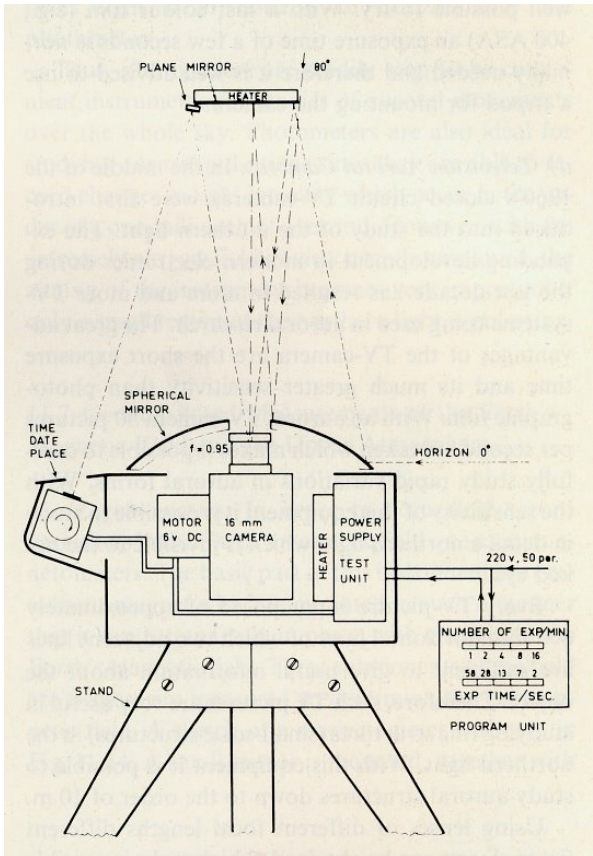
Figure 5. Block diagram of Stoffregen’s all-sky